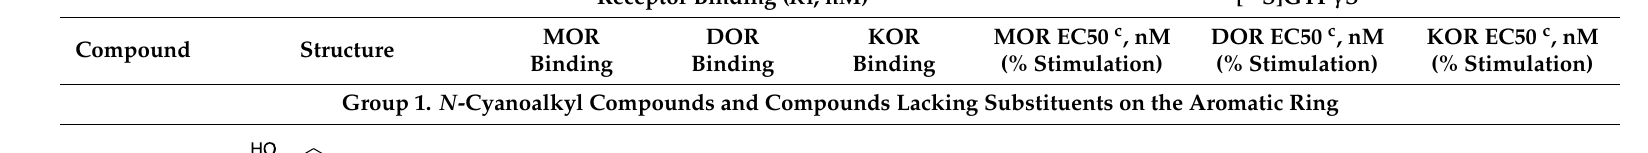
Table 1. Opioid Receptor Binding Data a ( K i, nM) and Stimulation of [ 35 S]GTP γ S b Binding at MOR ( µ ), DOR ( δ ) and KOR ( κ ) opioid receptors.